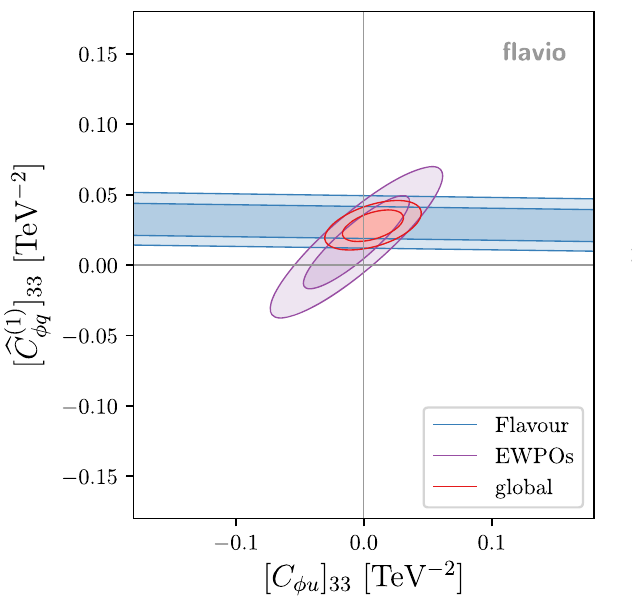
( 1 ) ] [ C ( 3 ) ] 3323 and 3323 at 1 TeV lq lq